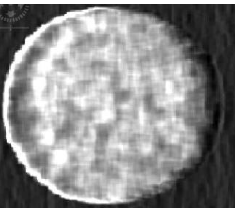
Figure 4: Height map of the simulated data